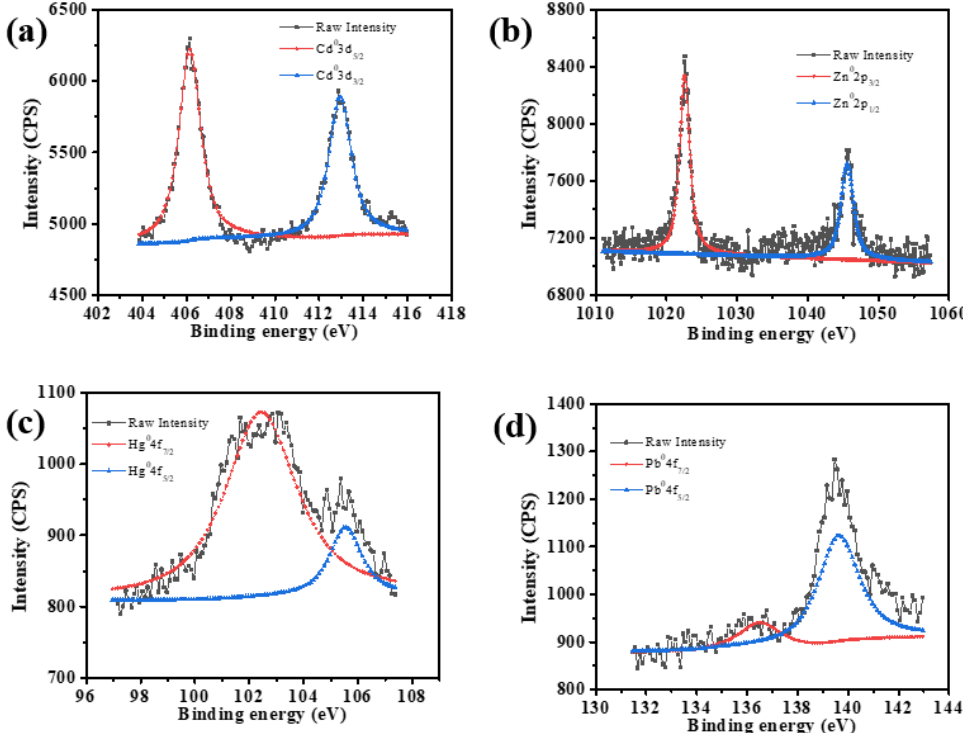
Figure 6. The XPS spectrum of the SMFCs cathode after the detection of Cd 2+ ( a ), Zn 2+ ( b ), Hg 2+ ( c ), or Pb 2+ ( d ).